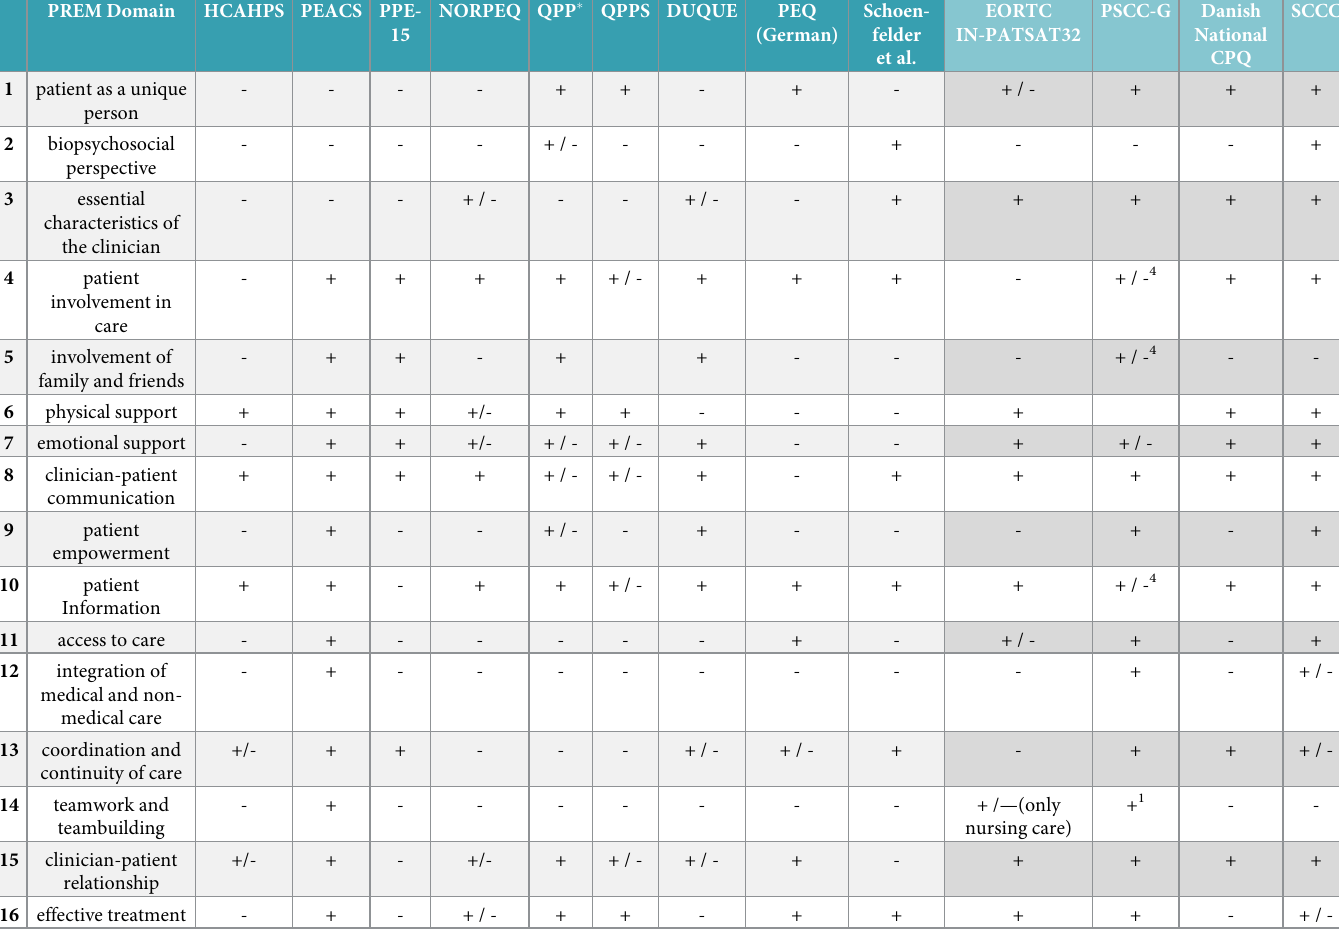
Table 3. Overview of content domains of German-language